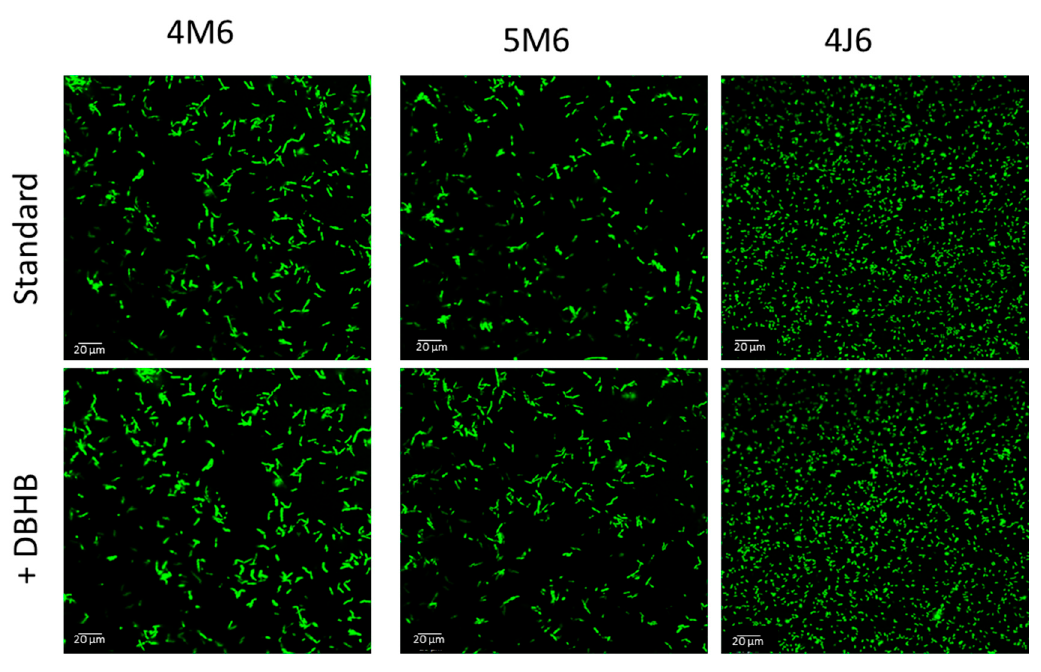
Figure 1. Impact of DBHB on the bacterial adhesion on glass surface at 20 °C without addition of DBHB (Standard) and containing DBHB at 16 μ M (+DBHB). Adhesion of Paracoccus sp. (4M6), Pseudolateromonas sp. (5M6) and Bacillus sp. (4J6) was observed by DBHB and detected by staining the cells with Syto 9. DBHB: Dibromohemibastadin. Sale bar: 20 µ m.